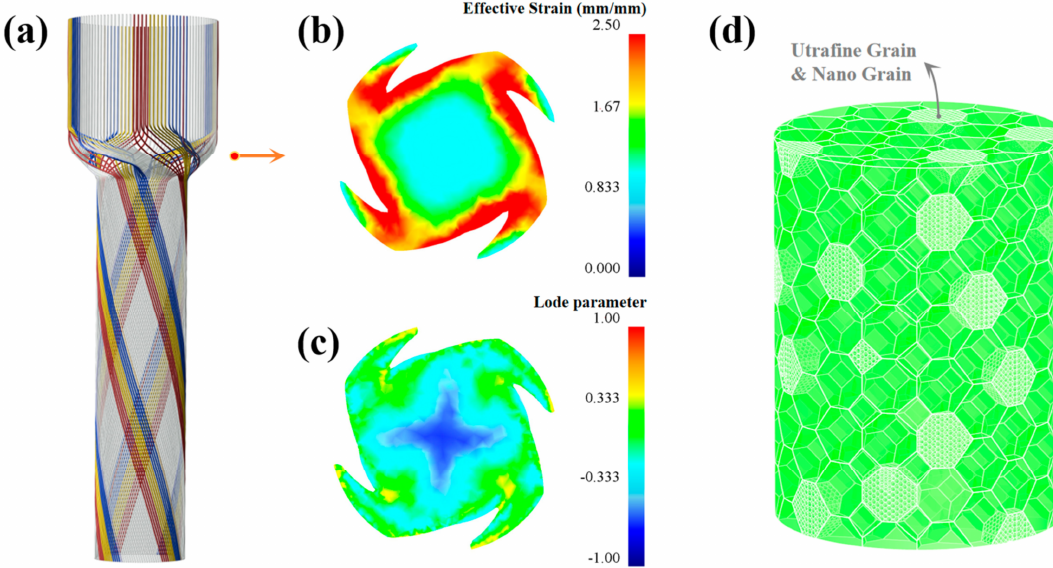
Figure 18. Schematic diagram summarizing the mechanism of microstructure evolution during FCE: ( a ) schematic diagram of the metal flow direction subject to FCE; ( b ) effective strain in the deformation zone; ( c ) load parameter in the deformation zone and ( d ) schematic diagram of the microstructure after